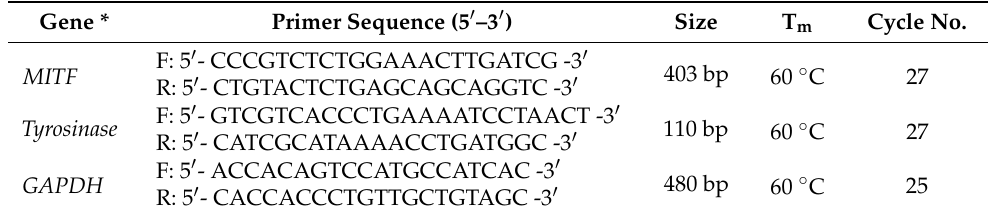
Table 1. Primers and PCR